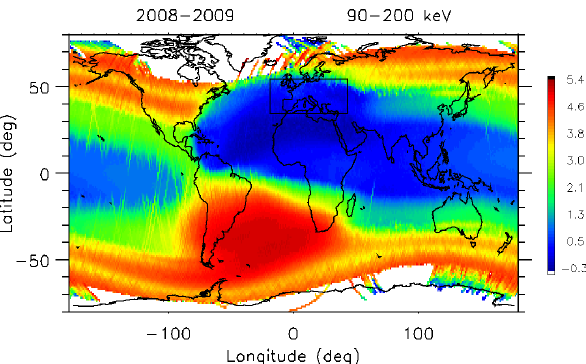
Figure 1. Geographical distribution of the electron integral flux be- tween 90 and 200keV at 700km at pitch angles close to 90 ◦ . The region selected over Europe to study the relationship between LEP and lightning is indicated by a black box. At the highest latitudes the large fluxes signal the outer radiation belt. Generally, the satellite does not deliver data at magnetic latitudes higher than 65 ◦ . How- ever, in several cases coordinated studies have been performed with ground-based auroral observatories. The corresponding passes can be seen over Scandinavia, Greenland, and Alaska, as well as over the conjugate regions. The region of high fluxes located around lat- itudes of 55 ◦ at a longitude of − 180 ◦ corresponds to the slot. The European region at latitudes lower than those of Scandinavia shows a weak background due to the fact that quasi-trapped electrons pre- cipitate inside the South Atlantic anomaly. The faint electron fluxes over southern Australia extending eastward are the signature of the effect of the North West Cape (NWC) VLF